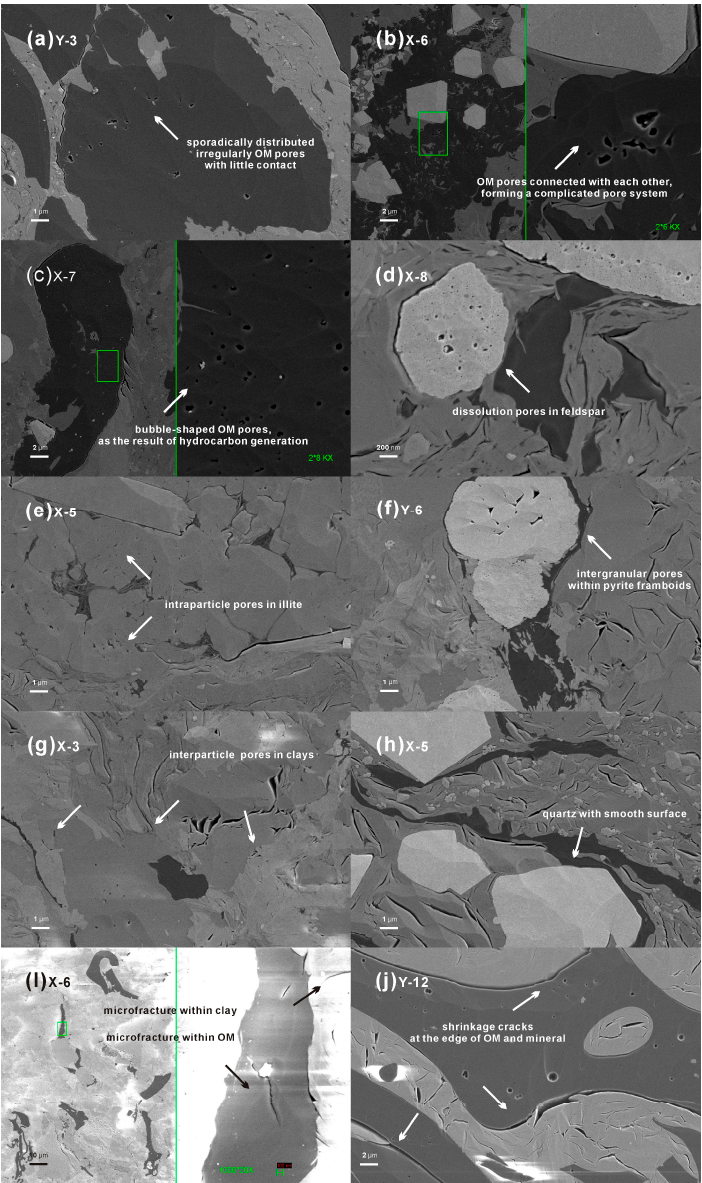
Figure 13. Scanning electron microscope (SEM) images showing major pore types of transitional Longtan Shale samples from YV-1 and XD-1. ( a ) Sporadically distributed irregularly organic matter (OM) pores with little contact; ( b ) OM pores connected with each other, forming a complicated pore system; ( c ) bubble-shaped OM pores within kerogen, as the result of hydrocarbon formation; ( d ) dissolution pores in feldspar; ( e ) intraparticle pores in illite; ( f ) intergranular pores within pyrite framboids; ( g ) interparticle pores in clays; ( h ) quartz with smooth surface; ( i ) microfractures within OM and clay; ( j ) shrinkage cracks at the edge of the OM and mineral.